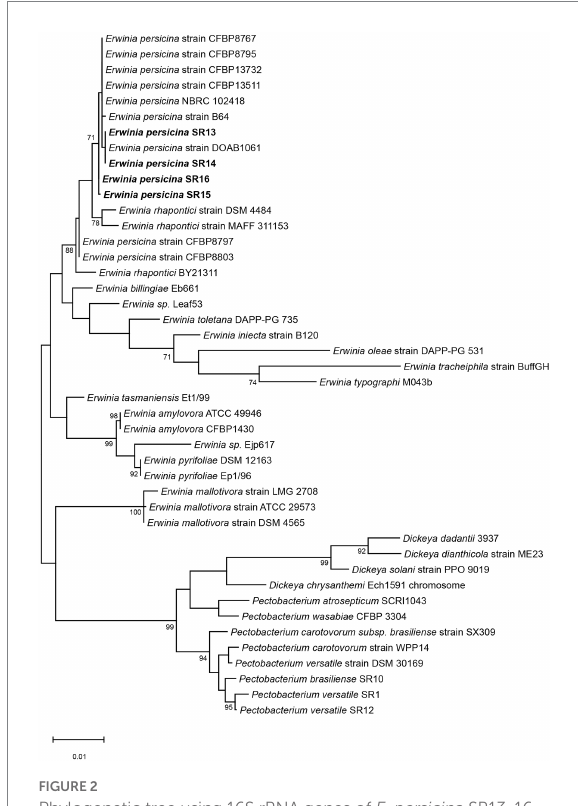
FIGURE 2 Phylogenetic tree using 16S rRNA genes of E. persicina SR13-16, other Erwinia species and common soft rot agents. The 16S rRNA genes of E. persicina SR13-16 isolates (in bold), various Erwinia, Dickeya, and Pectobacterium spp. strains were used to build the tree. Sequences of the 16S rRNA genes were collected from NCBI. The evolutionary history was inferred by using the Maximum Likelihood method and Tamura-Nei model. The tree with the highest log likelihood ( − 5331.53) is shown. The percentage of trees in which the associated taxa clustered together is shown below the branches. Initial tree(s) for the heuristic search were obtained automatically by applying Neighbor-Join and BioNJ algorithms to a matrix of pairwise distances estimated using the Tamura-Nei model, and then selecting the topology with superior log likelihood value. The tree is drawn to scale, with branch lengths measured in the number of substitutions per site. This analysis involved 44 nucleotide sequences. There were a total of 1,573 positions in the final dataset. Evolutionary analyzes were conducted in MEGA11.